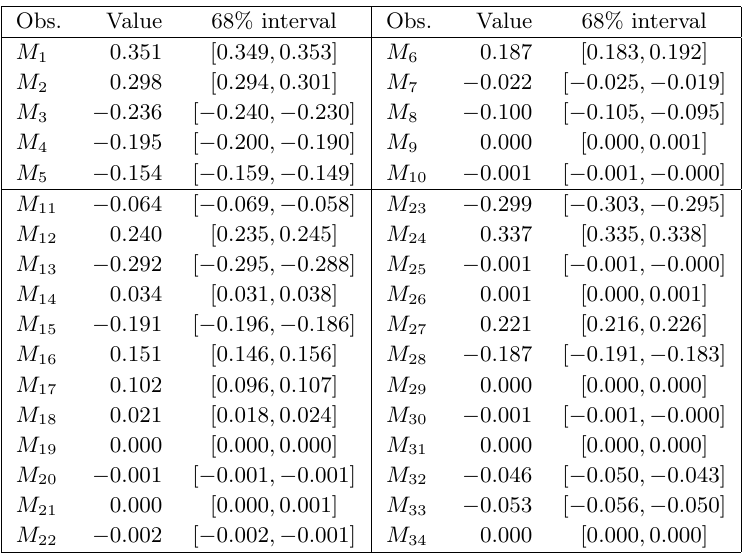
+ (cid:22) (cid:0) decay with P (cid:3) b = 1 b ! (cid:3) (cid:22)